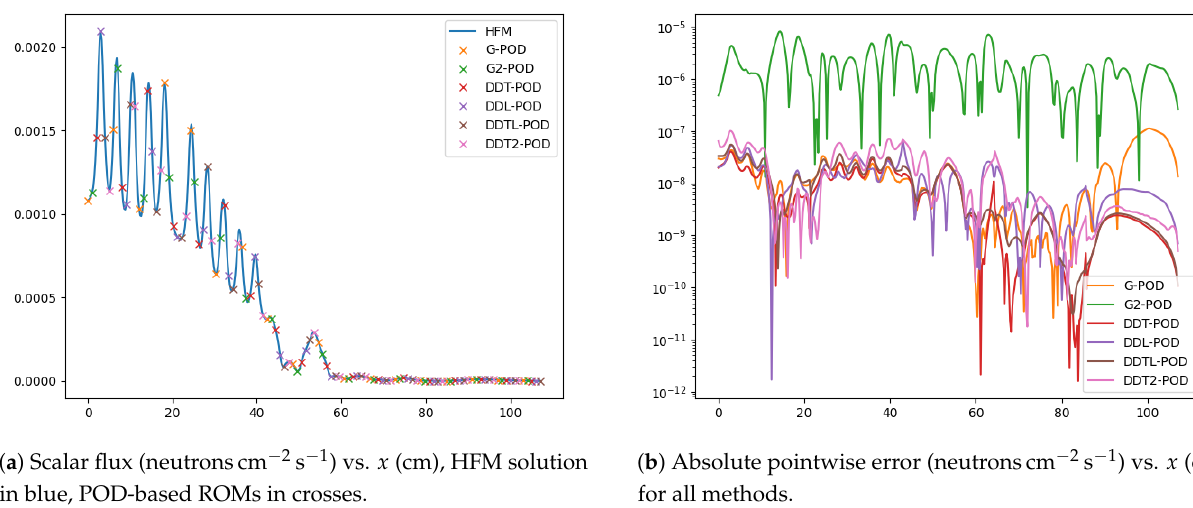
Figure 8. Scalar flux for Energy Group 17 for the HFM (blue) and POD methods and the pointwise error between them with parameters R 1 = 2, R 2 = 2, R 3 = 1, R 4 = 1, R 5 = 4.